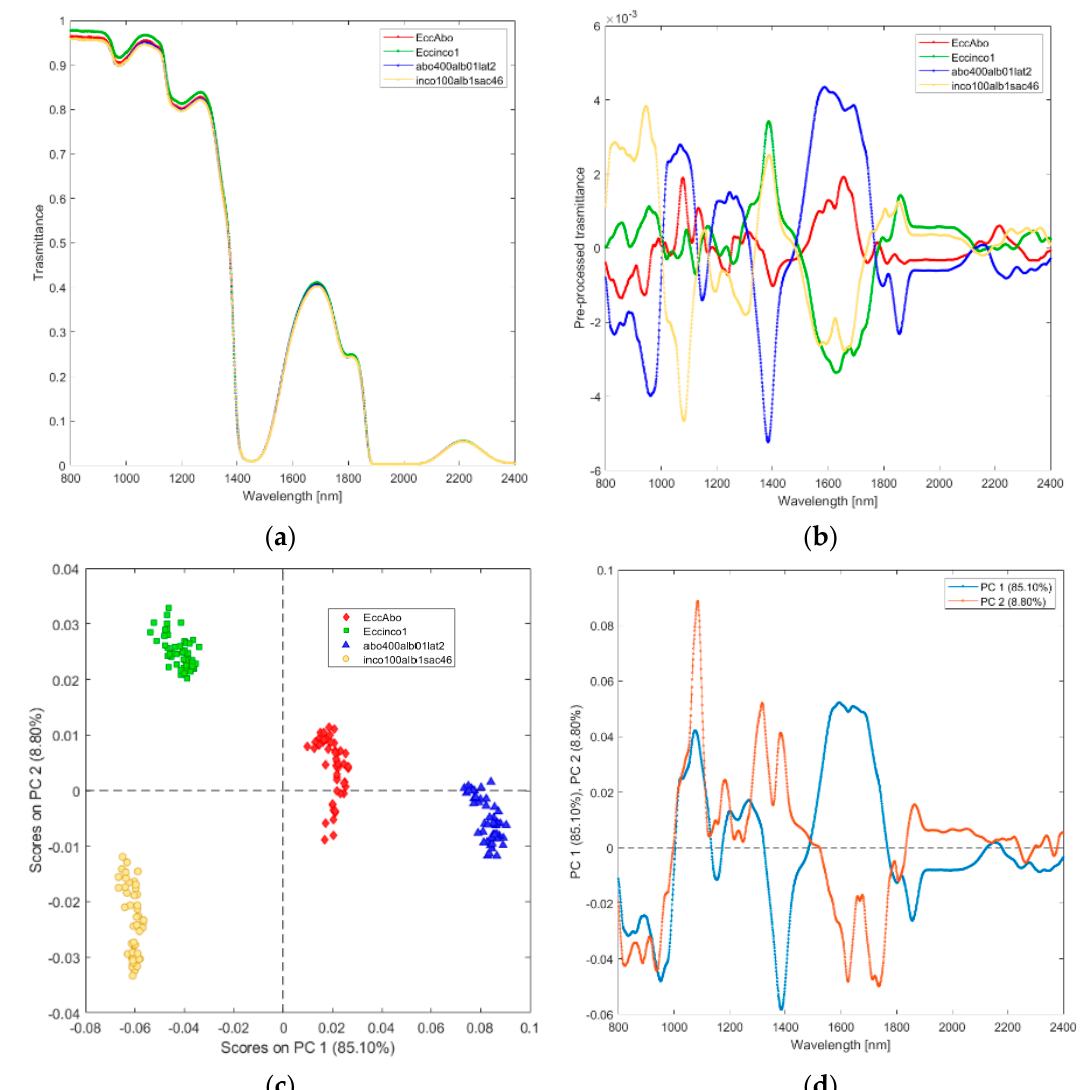
Figure 4. Average raw ( a ) and pre-processed ( b ) transmittance spectra for incobotulinum A toxin (inco100alb1sac46) and equiactive abobotulinum A toxin (abo400alb01lat2), and their excipients (EccInco, EccAbo). PC1 − PC2 score plot ( c ) and loading plot of PC1 and PC2 ( d ) for incobotulinum A toxin (inco100alb1sac46), equiactive abobotulinum A toxin (abo400alb01lat2), and their excipients (EccInco, EccAbo). (iv) Solutions of abobotulinum A toxin at standard clinical dilutions